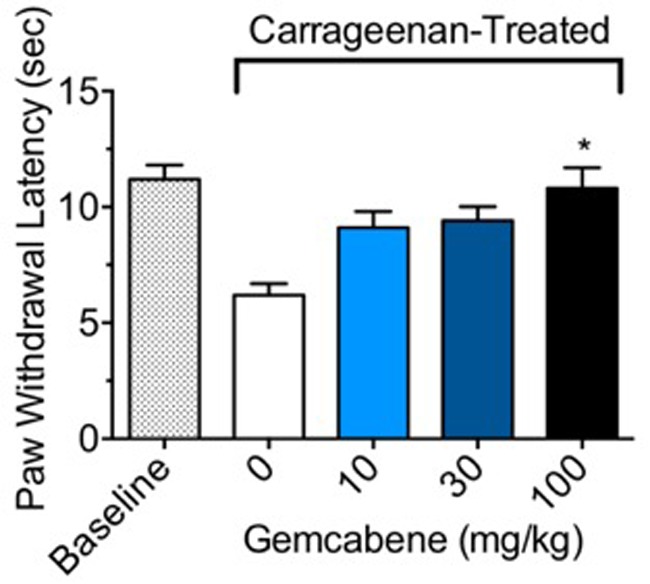
Effect of gemcabene on carrageenan-induced thermal hyperalgesia in the male Sprague Dawley rats. To induce inflammation, male Sprague Dawley rats were anesthetized and given an intraplantar injection of carrageenan (2 mg) in saline (0.1 mL). Rats (8/group) were injected with either saline (baseline) or carrageenan (control and drug treated) into the hind paw. For measurement of PWL responses, tests were done 1-h post drug administration (3.5 h post saline/carrageenan injection). Dose-related effects of gemcabene on paw withdrawal latency (PWL) was determined following exposure to radiant heat. ∗Significantly different from Carrageenan control. p < 0.05 as determined by one-way ANOVA/Tukey’s. Data are expressed as Mean ± SEM.